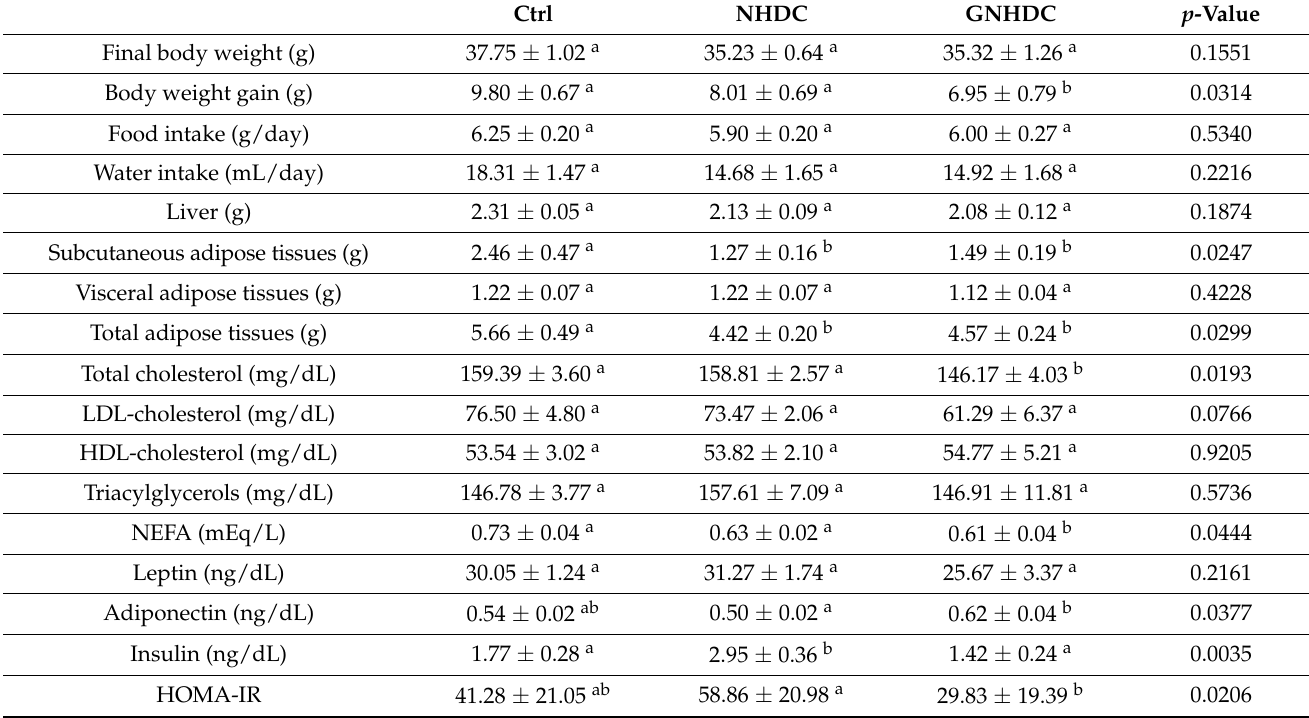
Table 3. Effects on body weight, tissue weight, plasma lipid profile, and cytokines in db/db